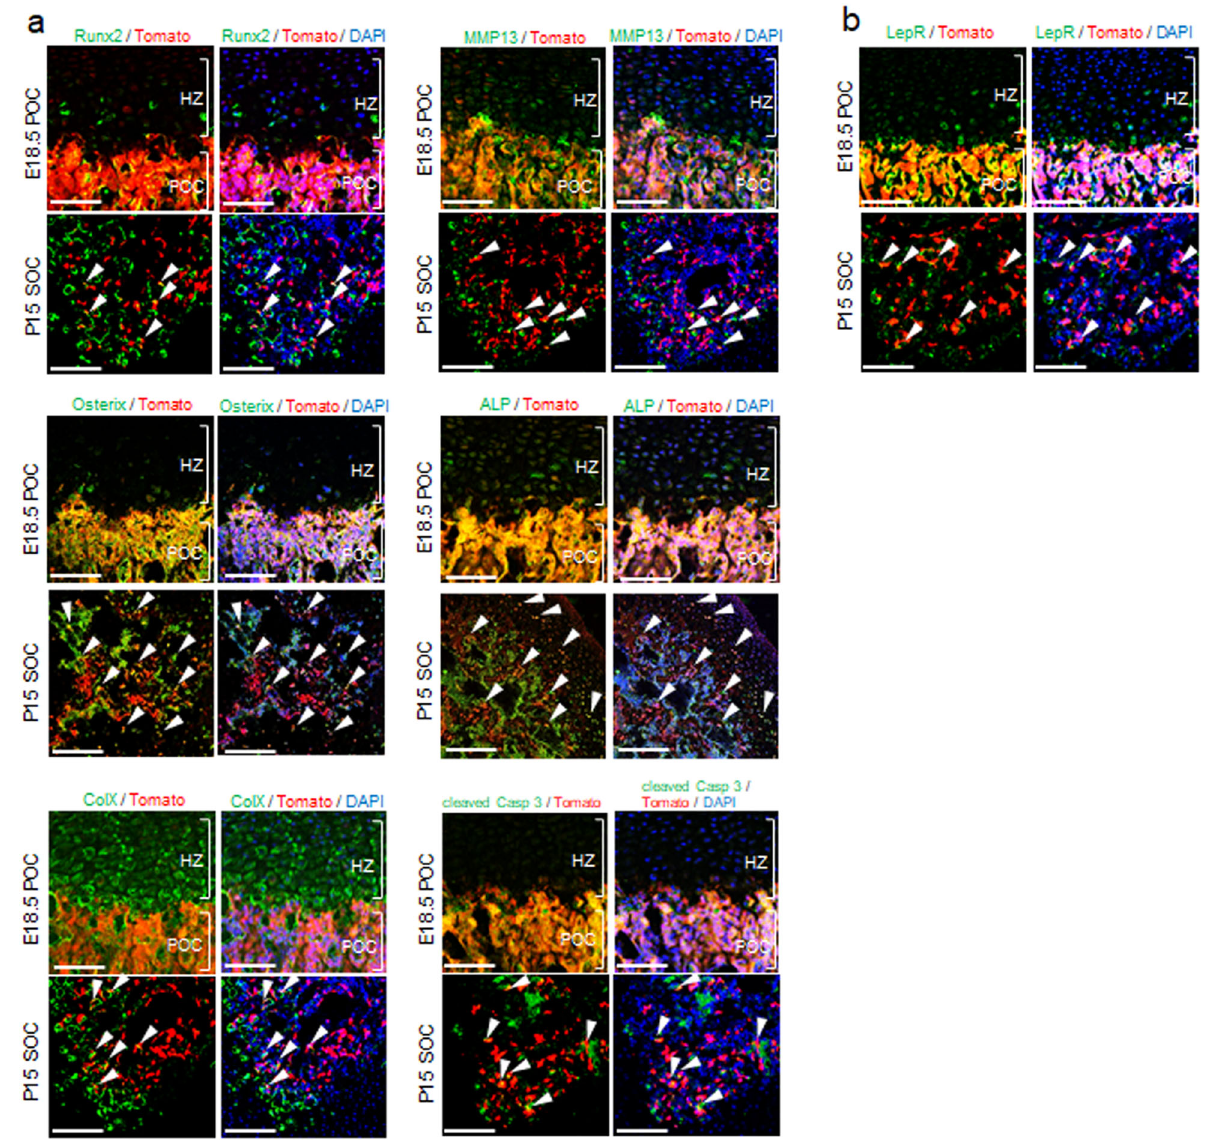
Fig. 2 LepR + MSCs contribute to endochondral ossi fi cation during embryonic and postnatal growth. a , b Immuno fl uorescence shows overlapping of Tomato + and the expression of Runx2, Osterix, collagen X, MMP13, alkaline phosphatase, cleaved caspase 3 and LepR in POC (E18.5) and SOC (P15) of Lepr-cre; tdTomato mice. Arrowheads indicate the overlapping of Tomato + and the expression of indicated markers. HZ = Hypertrophic zone; POC = Primary ossi fi cation center; SOC = Secondary ossi fi cation center; ColX = collagen X; ALP = alkaline phosphatase; cleaved Casp 3 = cleaved caspase 3. Scale bar, 100 μ